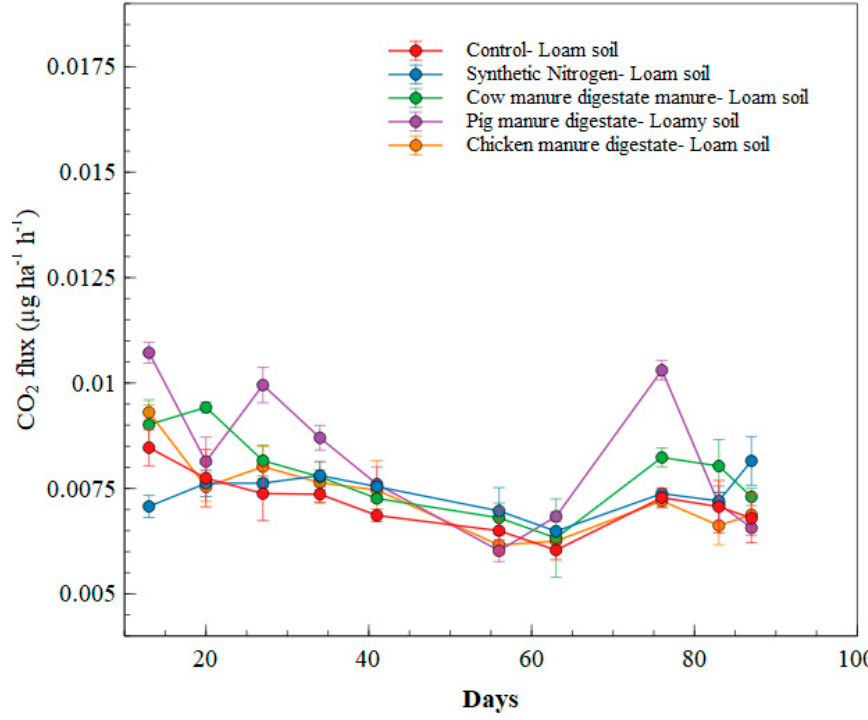
Figure 2. CO 2 emission flux of treatments in loam soil.